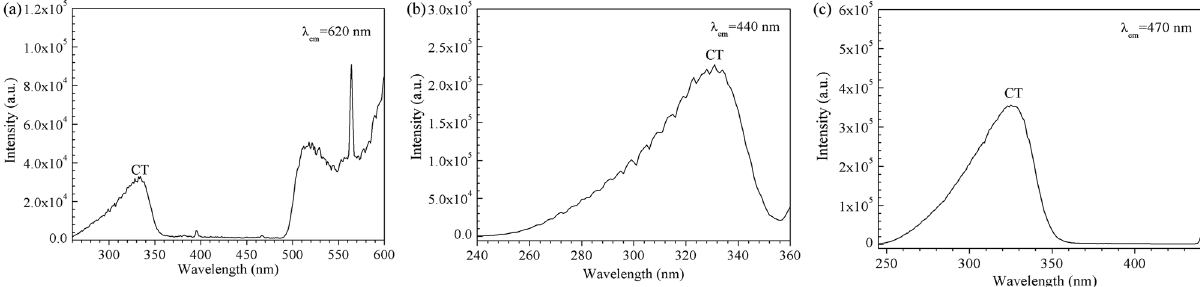
Figure 8: Excitation spectra of Ce 3 + - doped YVO 4 single crystal for 620 nm ( a ) , 440 nm ( b ) , and 470 nm ( c ) emissions at room temperature.